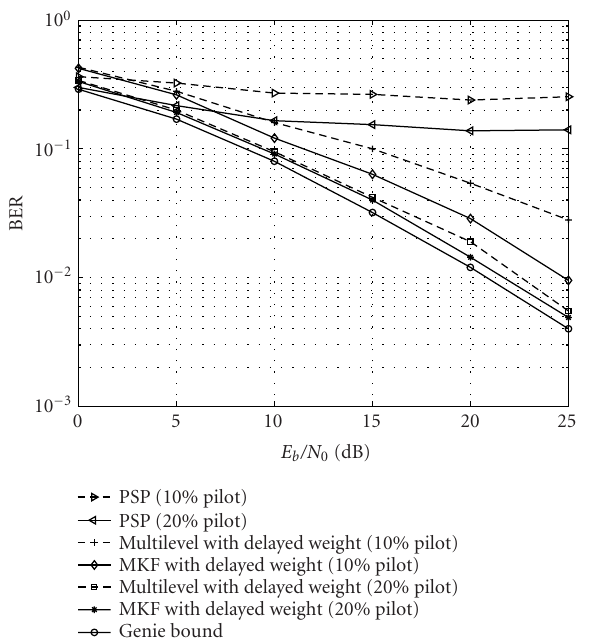
Figure 3: The BER performance of the PSP, the MKF with delayed weight ( δ = 10), and the multilevel MKF with delayed weight ( δ = 10) for pilot-aided 16-QAM over flat-fading channels.